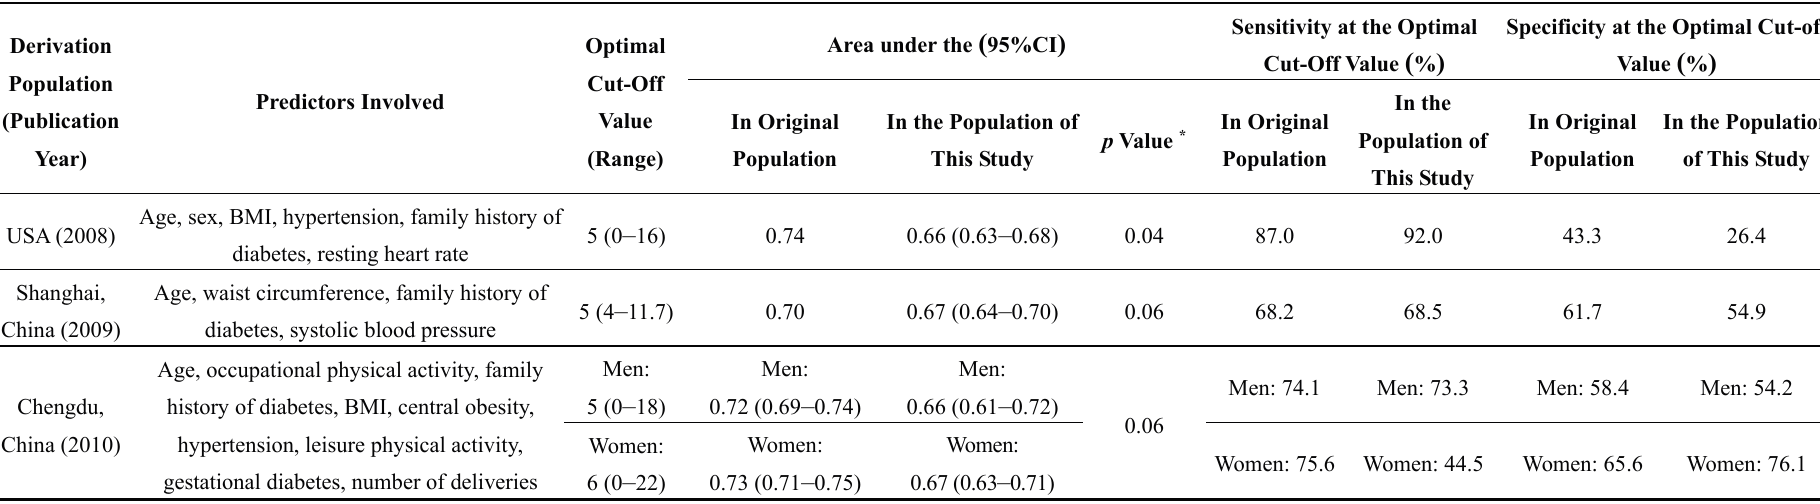
Table 5. Other pre-diabetes risk scores developed in other populations and performances in the current derivation study